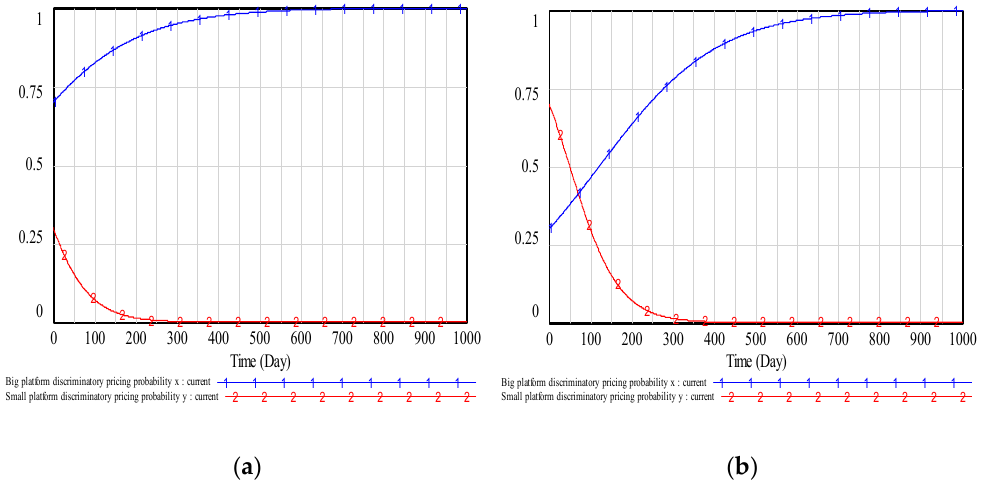
Figure 4. The dynamic evolution paths of case ③ . ( a ) The initial proportion pair of both types of platforms is ( 0.7,0.3 ) . ( b ) The initial proportion pair of both types of platforms is ( 0.3,0.7 )